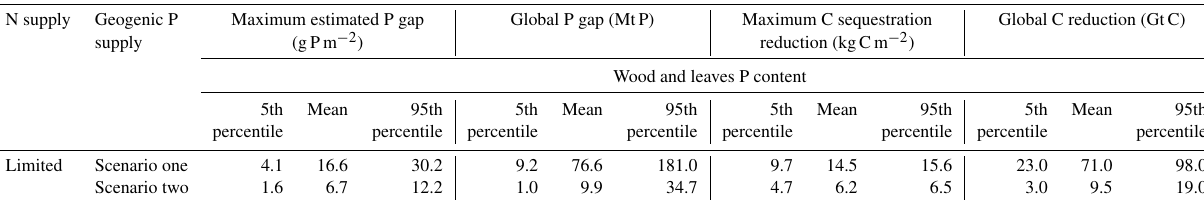
Figure 5. Areas with potential P gap for the nutrient budget of the N-limited AR scenario (after 94a of simulation), assuming P concentrations within foliar and wood material corresponding to mean values (Table 1). (a) Geogenic P supply scenario one (geogenic P from weathering plus atmospheric P deposition as source of P). (b) Basalt deployment necessary to close P gaps from P budget scenario of Fig. 5a. (c) Geogenic P supply scenario two (geogenic P from soil inorganic labile P and organic P pools plus atmospheric P deposition and P from weathering as source of P). (d) Basalt deployment necessary to close P gaps from P budget scenario of Fig. 5c. © ESRI. Table 3. Global P gap, maximum estimated P gap, maximum C sequestration reduction, and global C reduction for the natural N supply (N-limited) AR scenario (projected C sequestration of